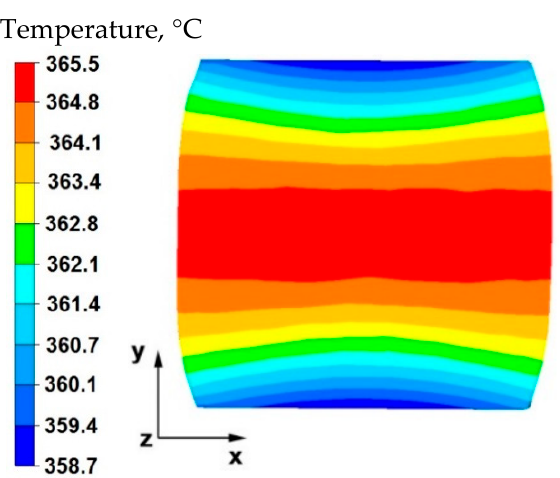
Figure 13. Distribution of temperature values on the surface of the cross-section of the sample with modeled discontinuity after rotation by 90° and re-deformation with 35% reduction.